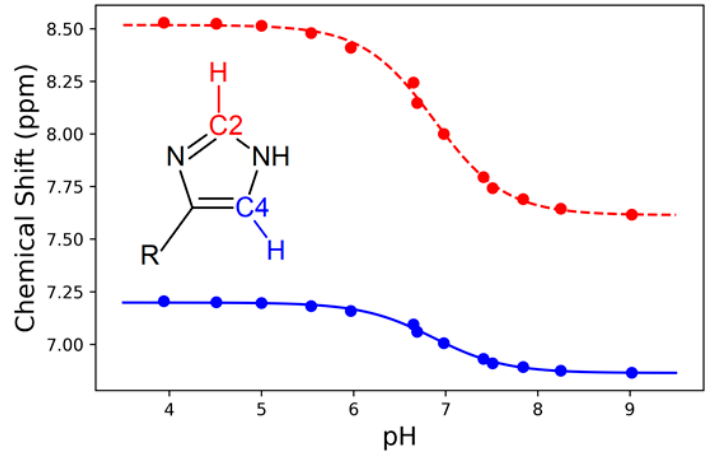
dose-response sigmoidal curve (Equation S1). The gray bar represents the error in the fitted midpoint.